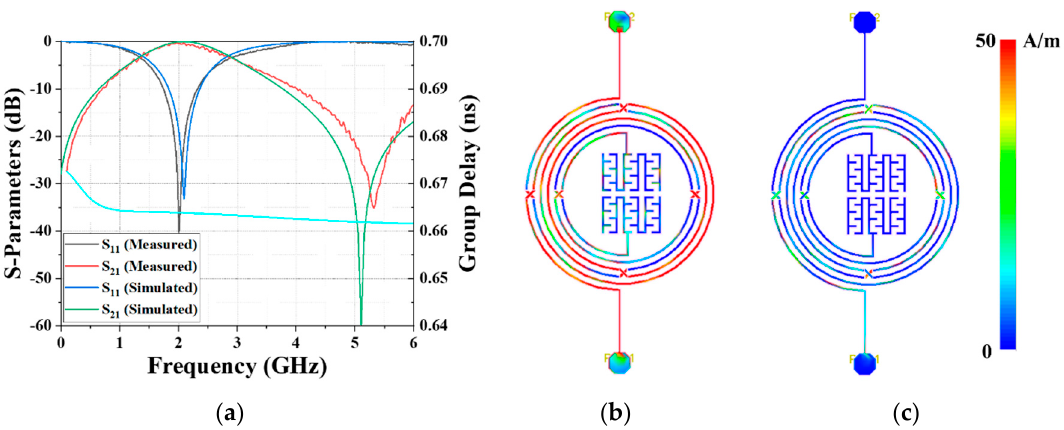
Figure 8. ( a ) Comparison of the measured and simulated results; current density at ( b ) 2.13 GHz and ( c ) 5.31 GHz. Table 3. Comparisons with other works using various manufacturing technologies Ref.